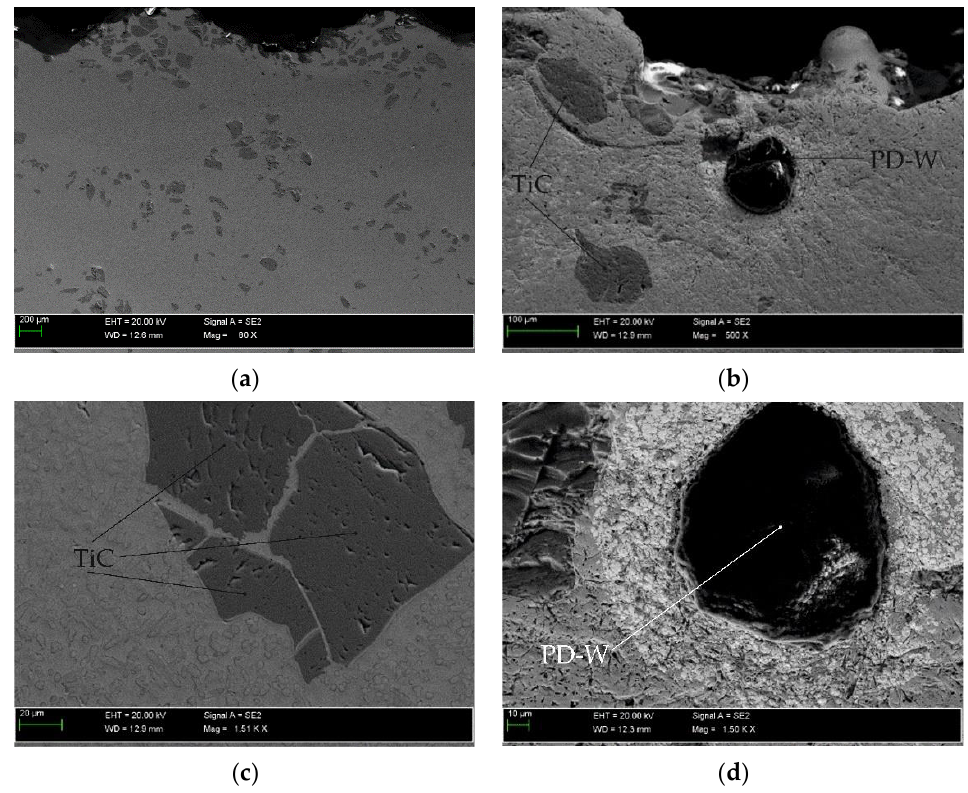
Figure 11. Microscopic image (SEM) of the surface layer (PPTAW metal deposition method, Co3+TiC+PD-W composite powder) deposited on structural low-alloy steel AISI 4715: ( a ) distribu- tion of ceramic particles in the matrix, ( b ) agglomerate of ceramic particles of crushed sharp-edged titanium carbide (TiC) and the spherical particle of the synthetic metal–diamond composite (PD-W), ( c ) single particle of titanium carbide (TiC) and ( d ) the single particle of the synthetic metal–diamond composite (PD-W) in the lagging of tungsten that partly passed to the solid solution of the cobalt alloy.